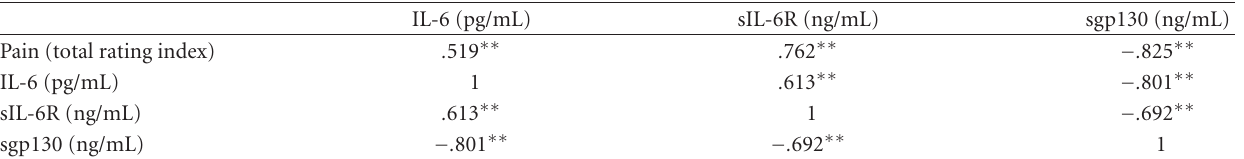
Table 2: Pearson correlation coe ffi cients among biological measures and pain perception.